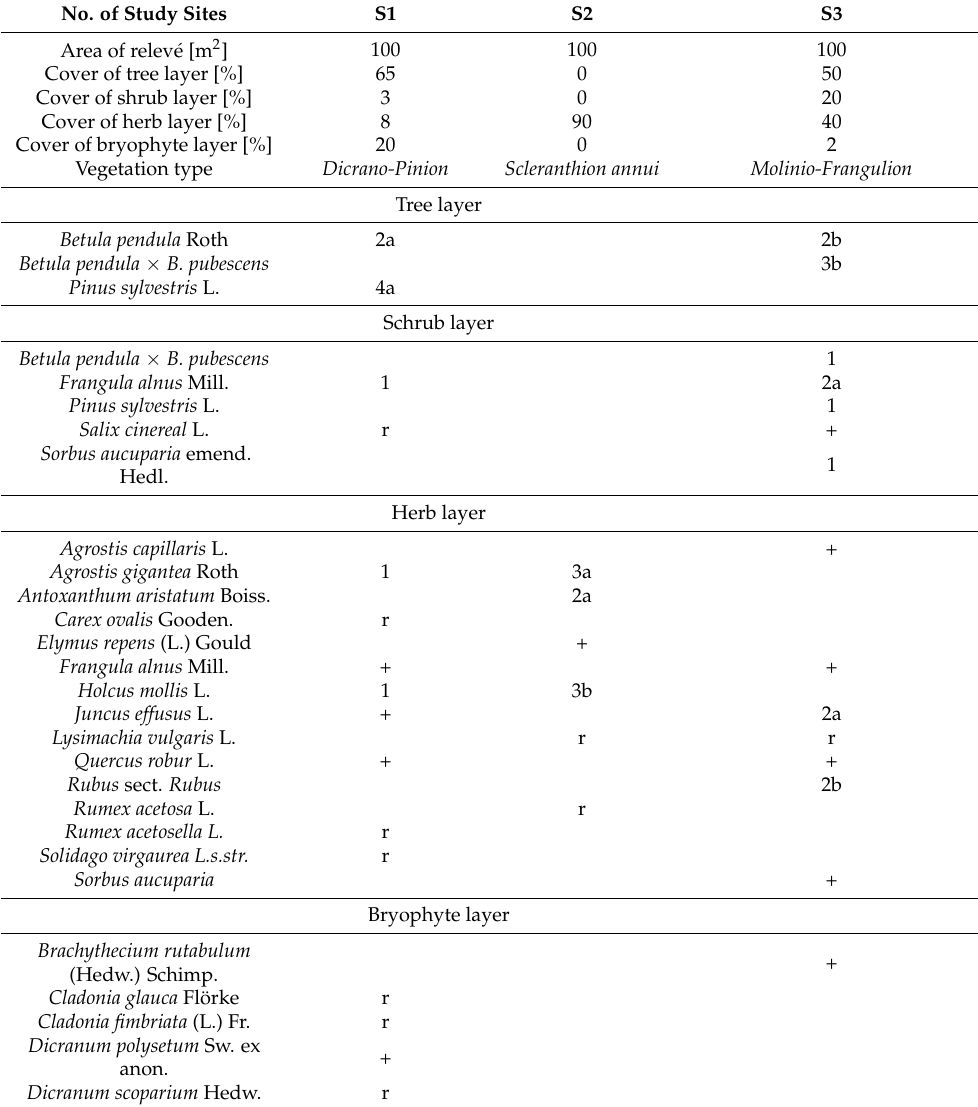
Table 2. Vegetation characteristics of the studied